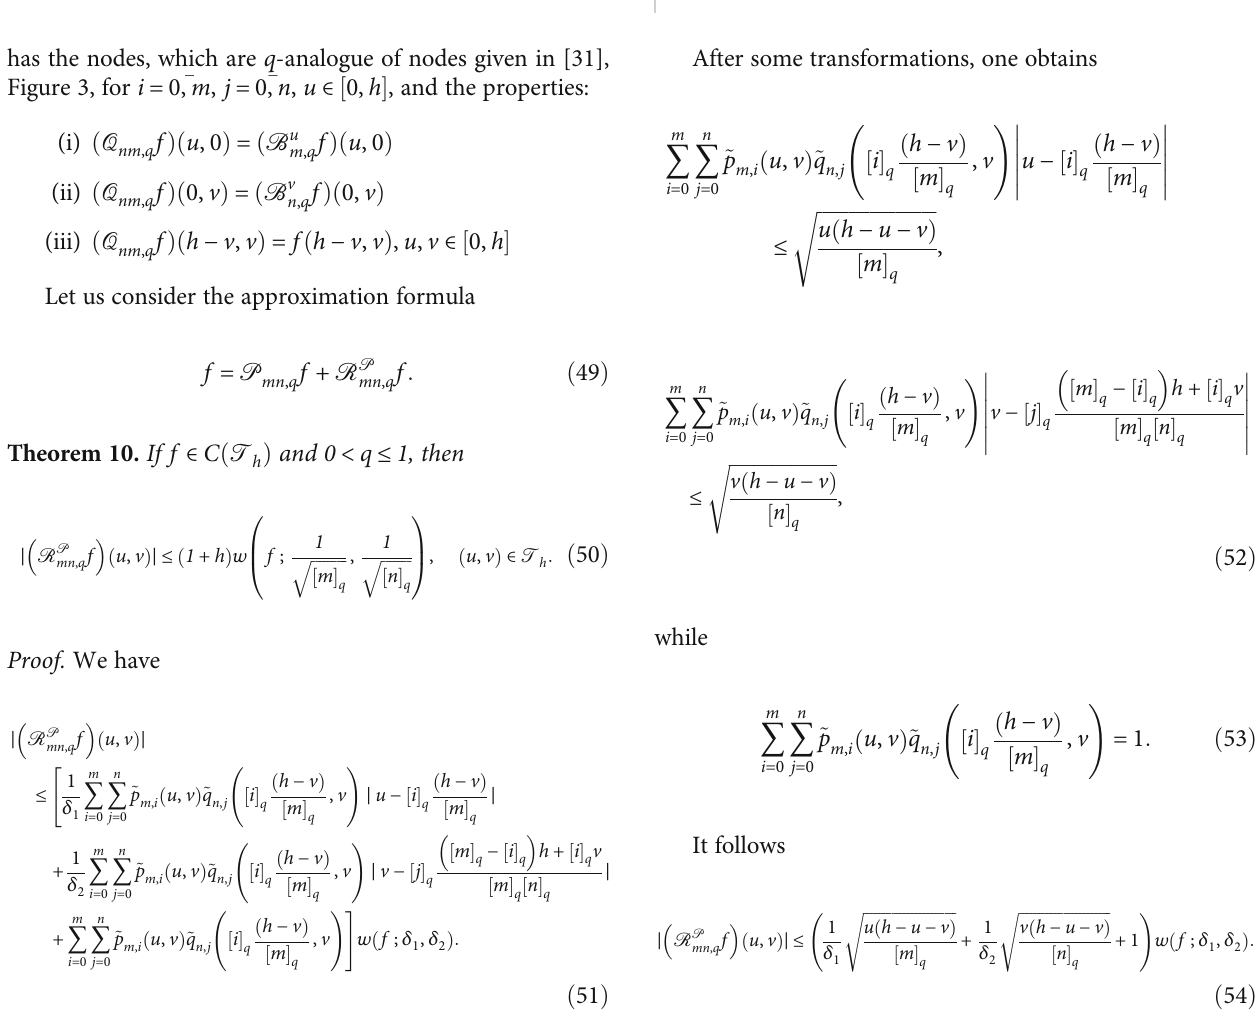
ffiffiffiffiffiffiffiffiffiffiffiffiffiffiffiffiffiffiffiffiffiffiffi v h − u − v